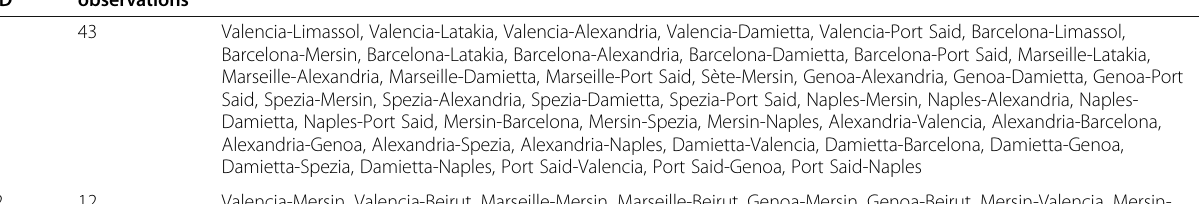
Table 15 Clustering Results - Optimized Network Cluster N. of ID observations